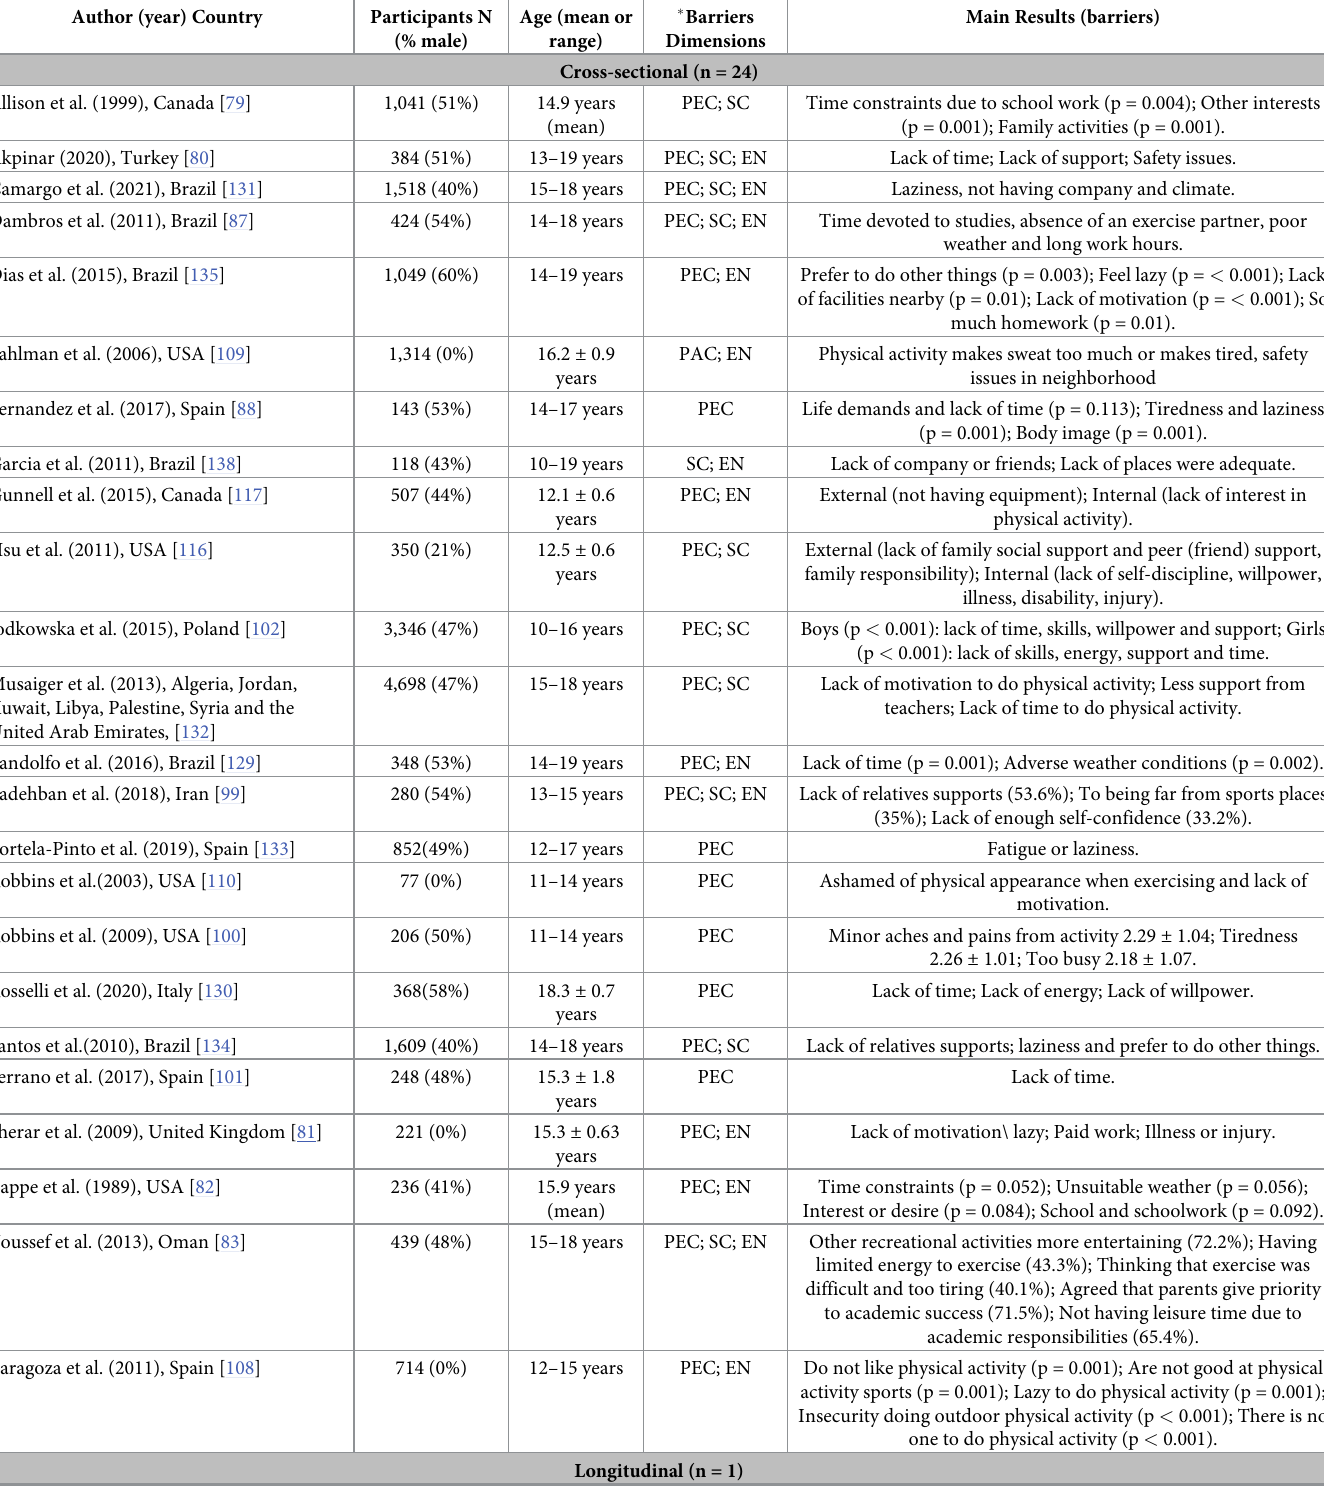
Table 2. Characteristics of the studies examining barriers to physical activity in high school